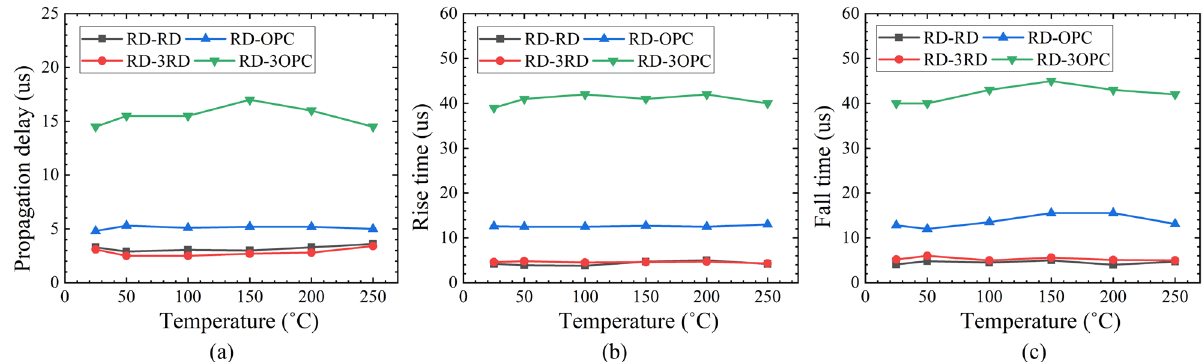
Figure 10. Transient measurement results of optocouplers with varying temperatures: ( a ) propagation delay, ( b ) rise time, and ( c ) fall